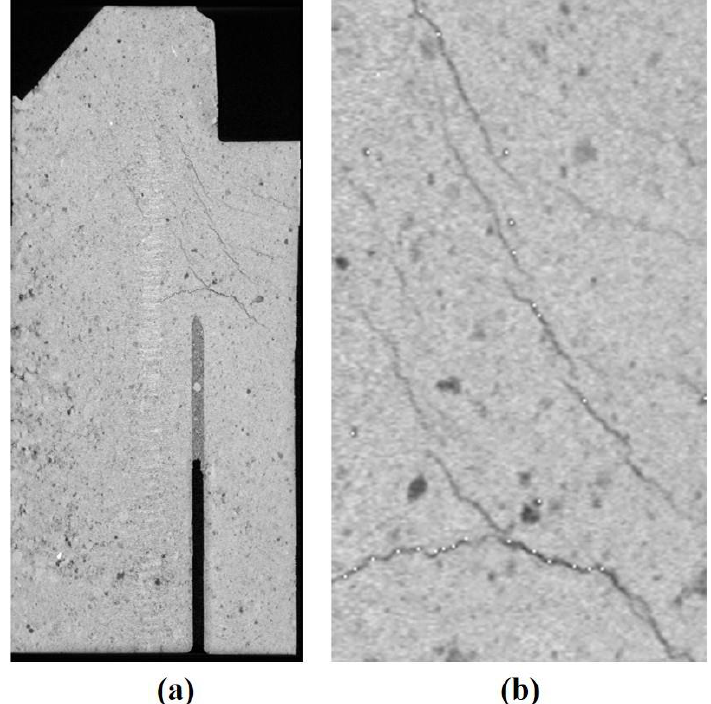
Figure 5. Seed voxels (white voxels, some are identified with black arrows) of a typical anode image (center of the slice) containing cracks and pores: ( a ) full scale; ( b ) image zoomed in the region containing most cracks.